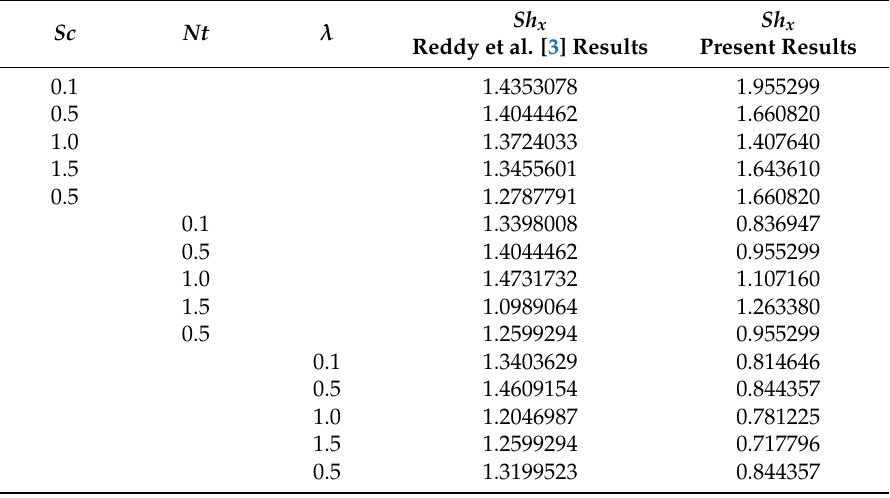
Table 3. Variation in the Sherwood Number of dissimilar parameters ω = M = EI = Rd = Pr = β =